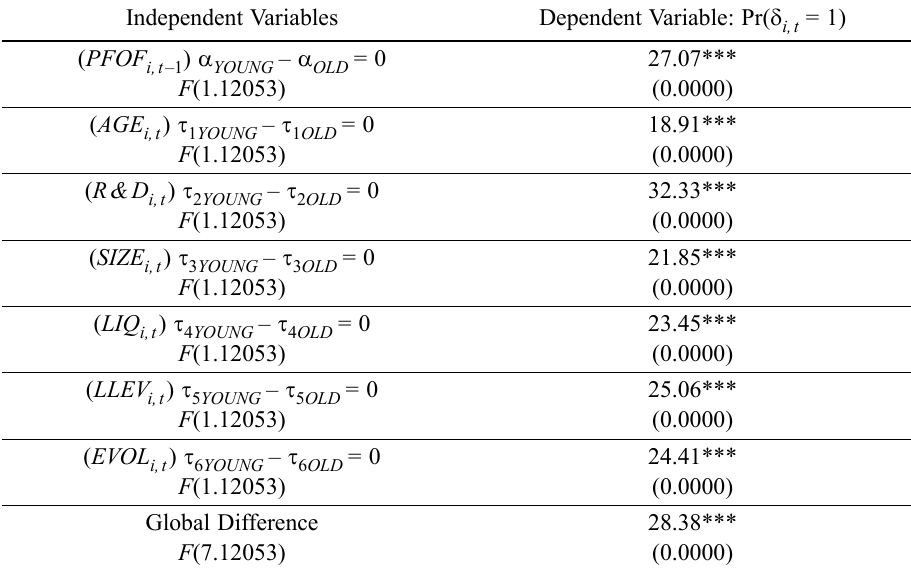
Table 5. Chow test – differences for determinants of survival – Young SMEs and Old SMEs Independent